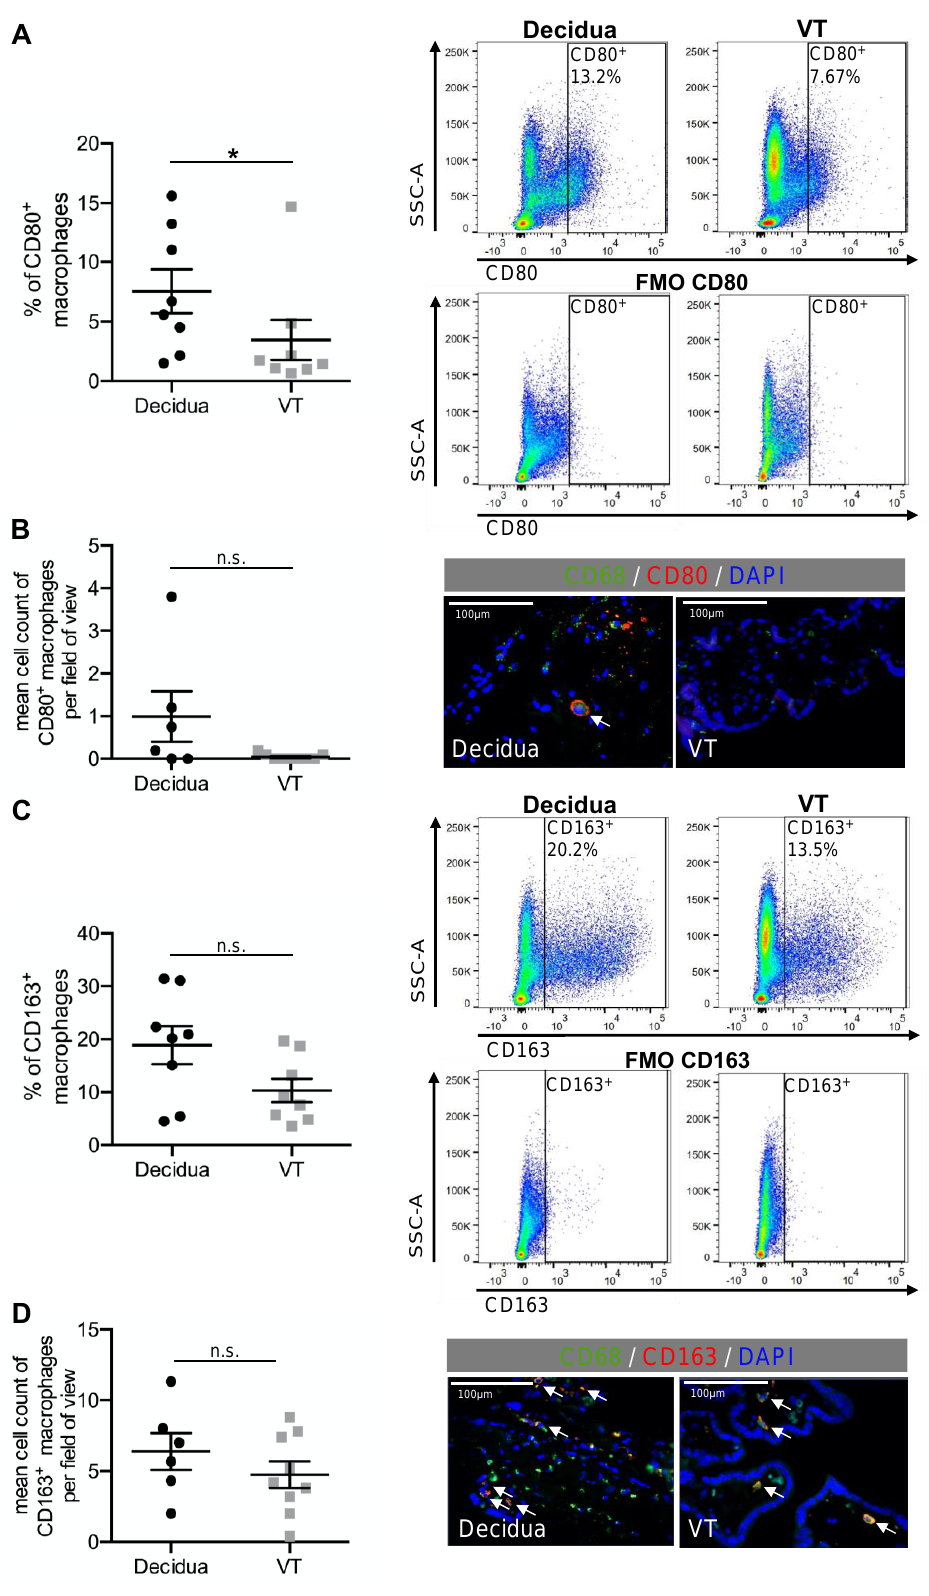
Figure 2. Expression of pro- and anti-inflammatory surface markers in decidual macrophages and Hofbauer cells (VT). ( A ) Dotplots of the left graph show the percentage of CD80 + macrophages